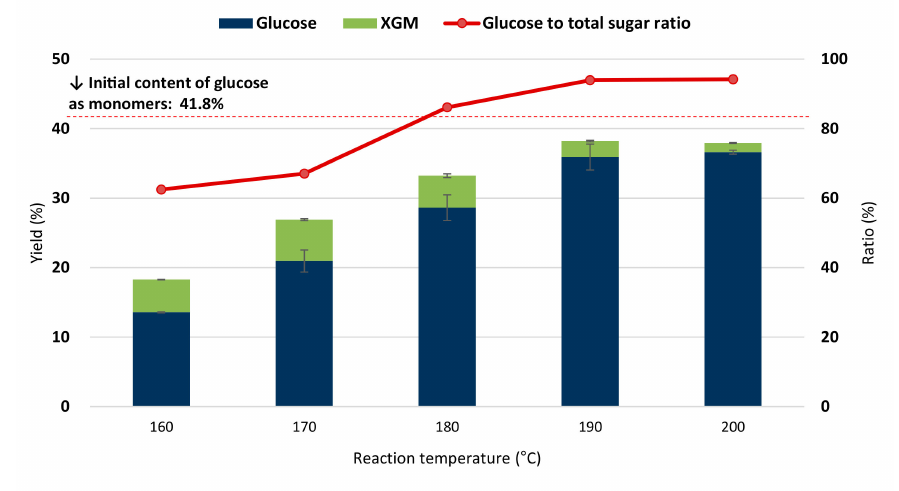
Figure 3. Glucose yield and glucose to total sugar ratio after enzymatic